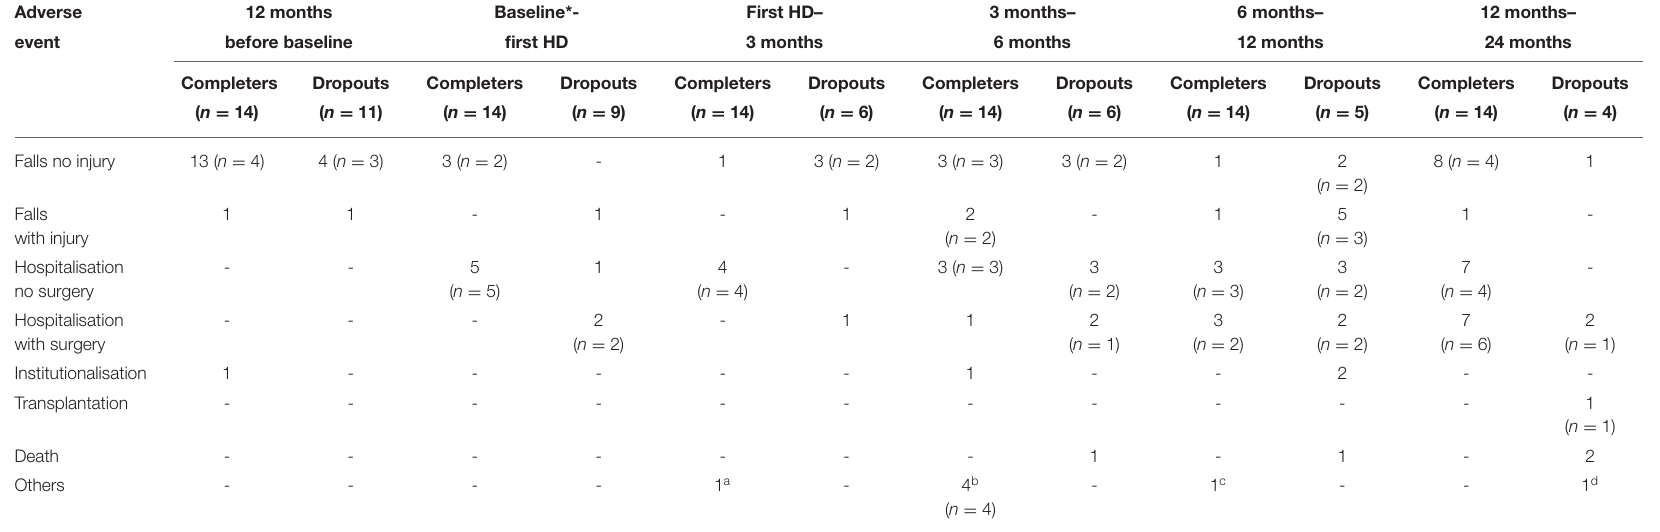
TABLE 3 | Adverse